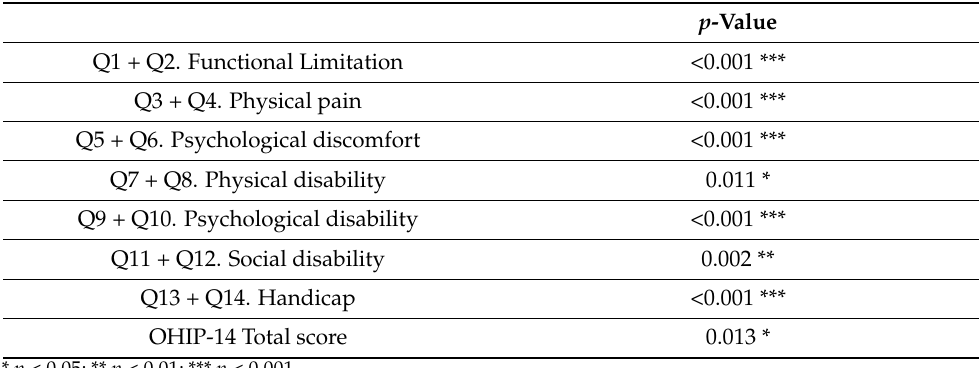
T0: Kruskal–Wallis test